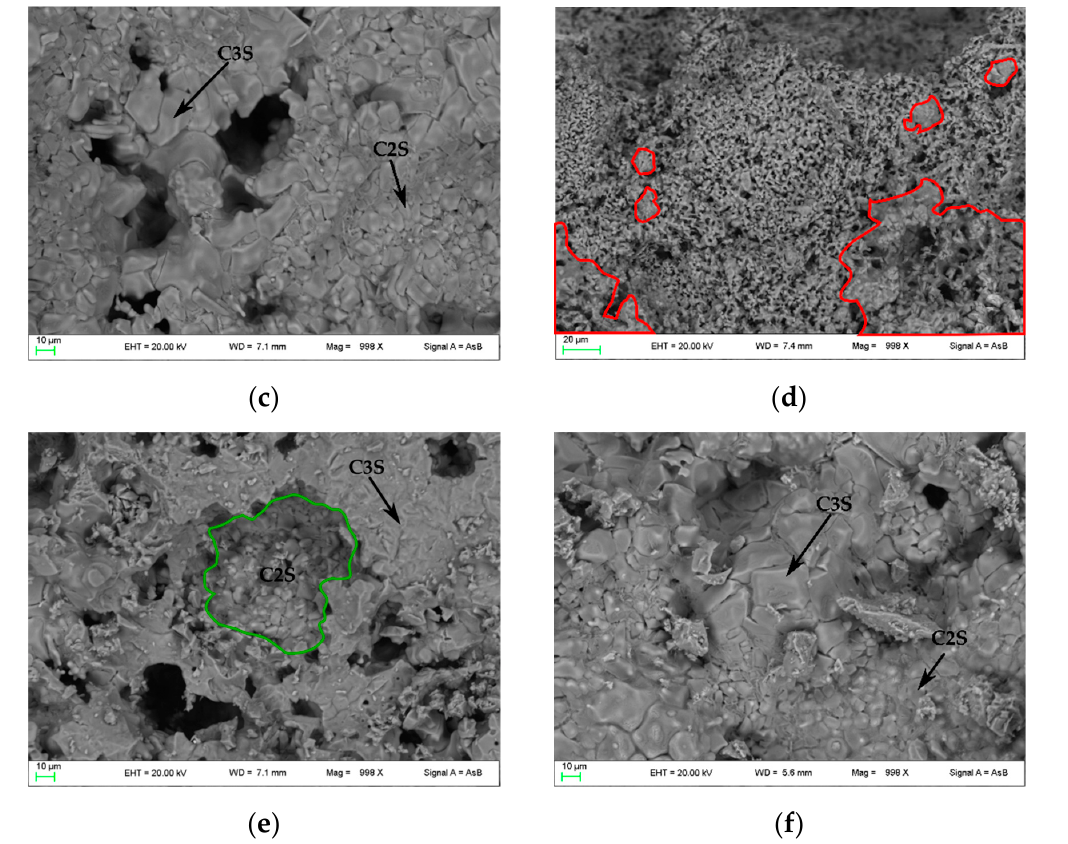
Figure 4. FESEM images of the clinkers ( a ) PC1250c, ( b ) PC1350c, ( c ) PC1450c, ( d ) nPC1250d, ( e ) nPC1350d, and ( f ) nPC1450d. The red areas highlight regions where mineralogical reactions started in clinkers burned at 1250 °C. The green area highlights a belite nest in nPC1350d. The C3S and C2S grains are also shown in clinkers burned at 1350 °C and 1450 °C.